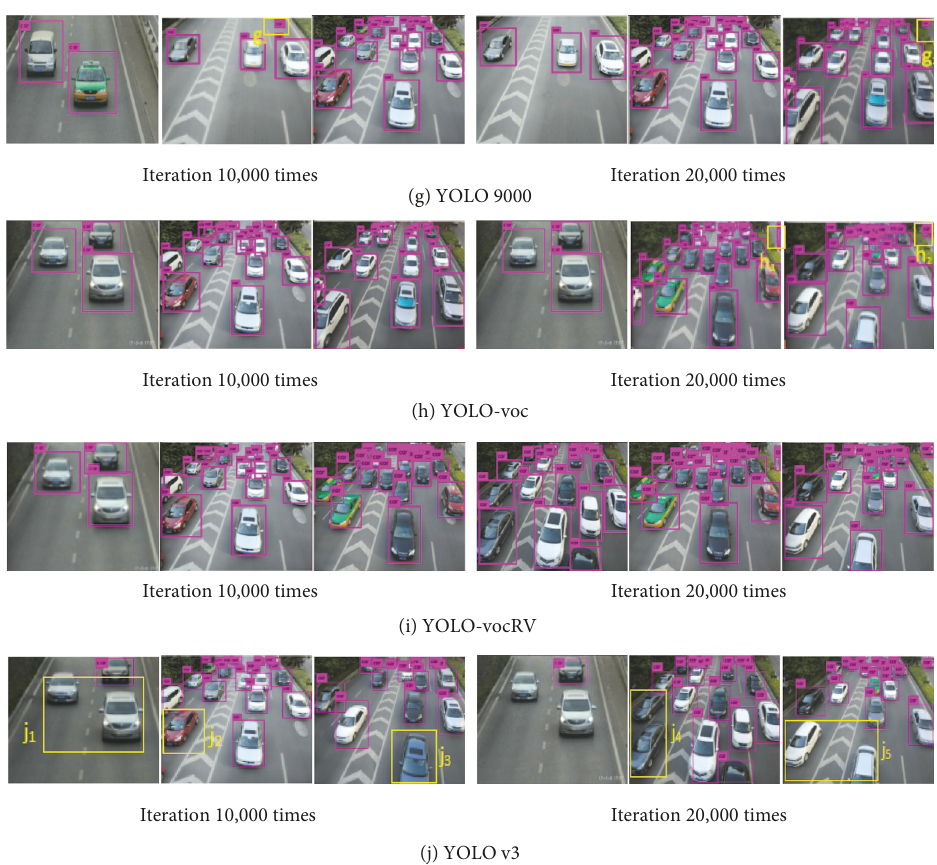
Figure 14: Test results for training samples with blocking